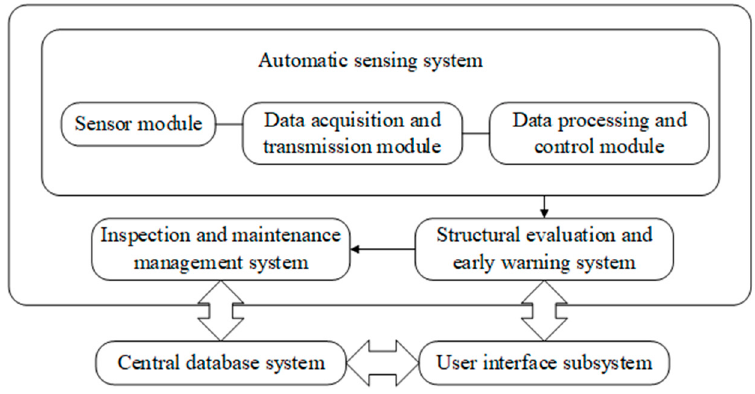
Figure 3. SHM system of the HZMB.